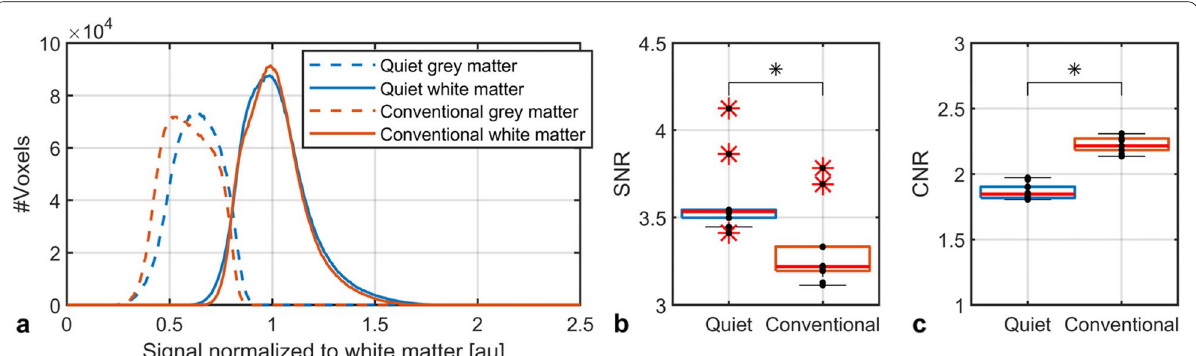
Fig. 2 Results from quantitative image assessment. a Histogram of the normalised signal intensities of grey and white matter for the quiet and conventional sequence for all subjects. b Box plot of the signal-to-noise ratio in each subject. c Box plot of the contrast-to-noise ratio for all subjects. Asterisk indicates statistical significance ( p < 0.05; Wilcoxon signed-rank